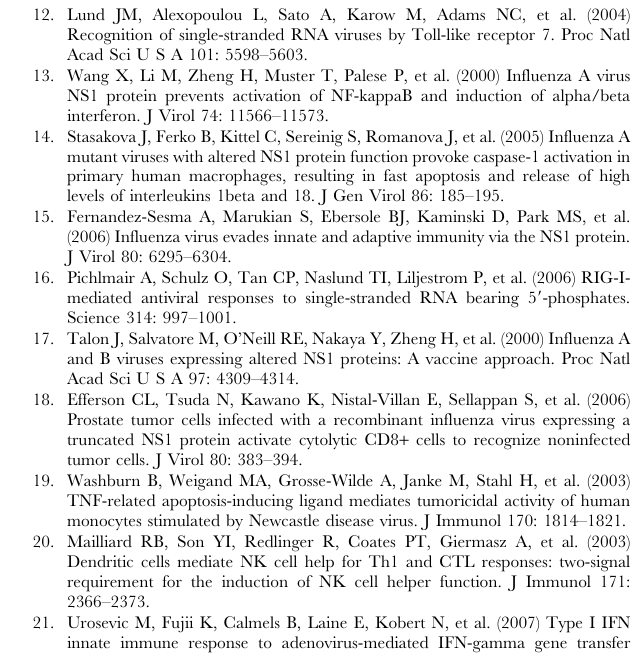
Figure S2 Neutralizing influenza heamagglutinin (HA) anti- serum does not reduce cytotoxicity of delNS1-virus stimulated PBMCs. PBMCs were mock-treated or infected with delNS1 virus (m.o.i.= 0.02) and were incubated for 24 hours. HA anti-serum was added to the PBMCs culture 1h prior the co-cultivation with the tumor cells. The viability of the tumor cells was determined after 24h of co-culture. One representative result out of three independent experiments, each performed with PBMCs derived from a different donor, is shown. Figure S3 Neutralizing influenza heamagglutinin (HA) anti- serum inhibits Vero cells killing mediated by the infection with delNS1. The neutralizing HA-anti serum was added to the virus suspension 1h prior infection of the Vero cells. The Vero cells were infected at the m.o.i. of 0.2 either with the untreated or with the HA-anti serum neutralized delNS1 virus. The control group was left uninfected (mock). The viability of the Vero cells was determined 48h after infection by means of colorimetic Easy for You Assaz